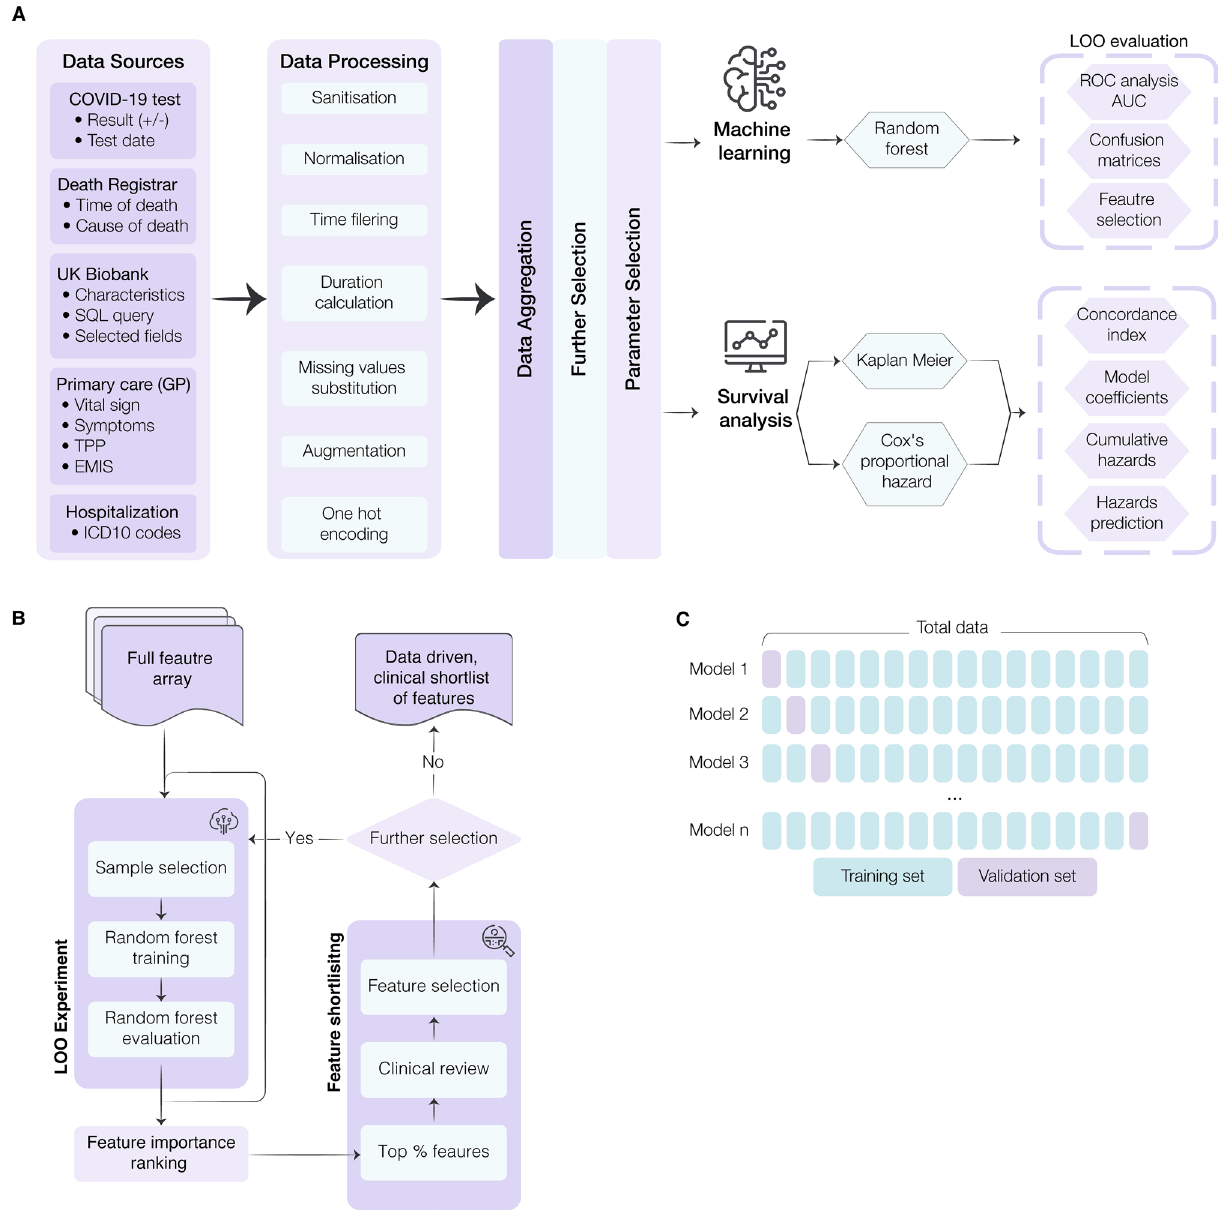
Figure 1. Workflow for model development and feature selection. ( A ) Conceptual diagram of the data ingestion pipeline and analysis methods. To combine databases, several data pre-processing steps were carried out, including: sanitisation (eliminating redacted records and nuanced entries); normalization (scaling values to ensure fitting with a reasonable range for further processing); time filtering; duration calculation (computing the time interval between testing positive and mortality); missing value substitution (replacing missing values or records with the mean value of the UK Biobank database); augmentation (bringing all data for each subject into a single unified record); and one-hot-encoding (codifying the presence of a pre-existing condition or symptom into a binary sequence for each subject). This data ingestion process standardized the input features and attributes for all subjects in this study regardless of their unique and variable conditions, symptoms, vital signs, and records. ( B ) Illustration of the data-driven and clinically reviewed feature refinement process. ( C ) Schematic representation of the leave-one-out cross-validation method for feature selection and model validation. Each sample is systematically left out in each fold (purple). Prediction error estimates are based on left out samples. AUC = area under the curve; GP = general practice; LOO = Leave-One-Out; ROC = receiver operating